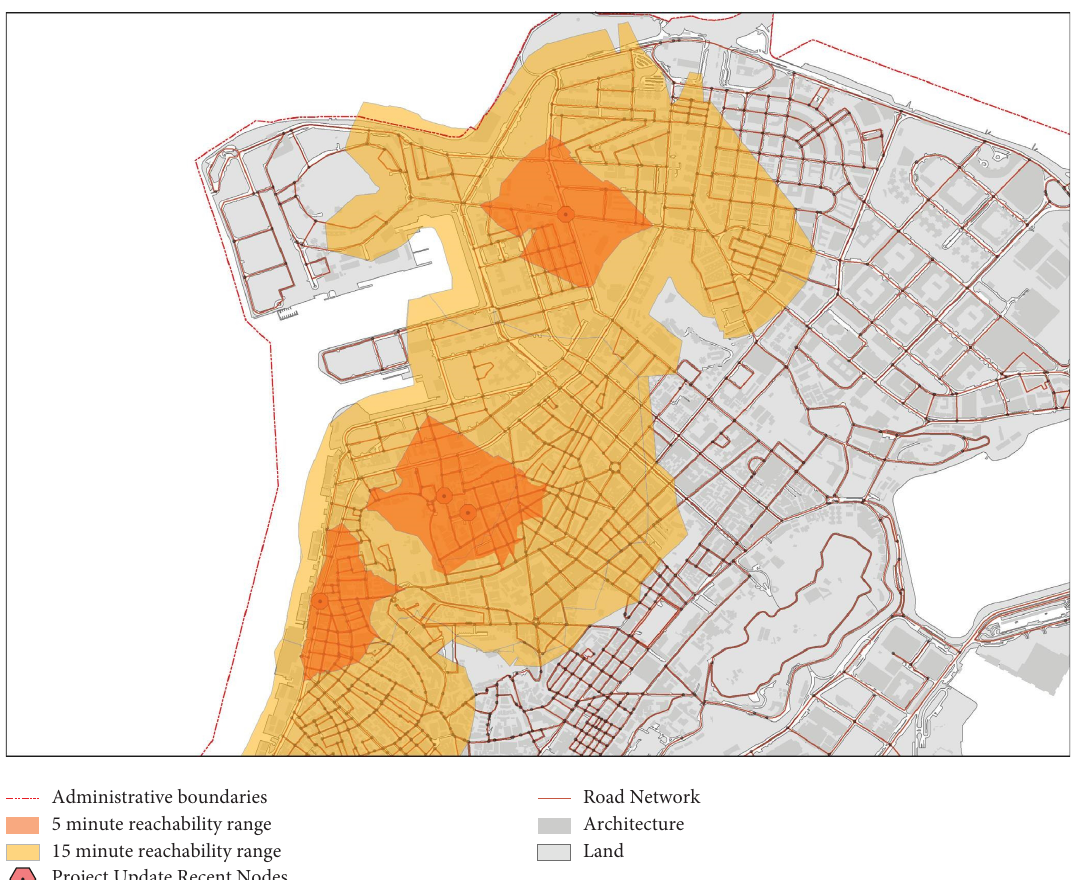
Figure 4: Assessment of the accessibility of Macau’s urban renewal space (source: self-drawn by the